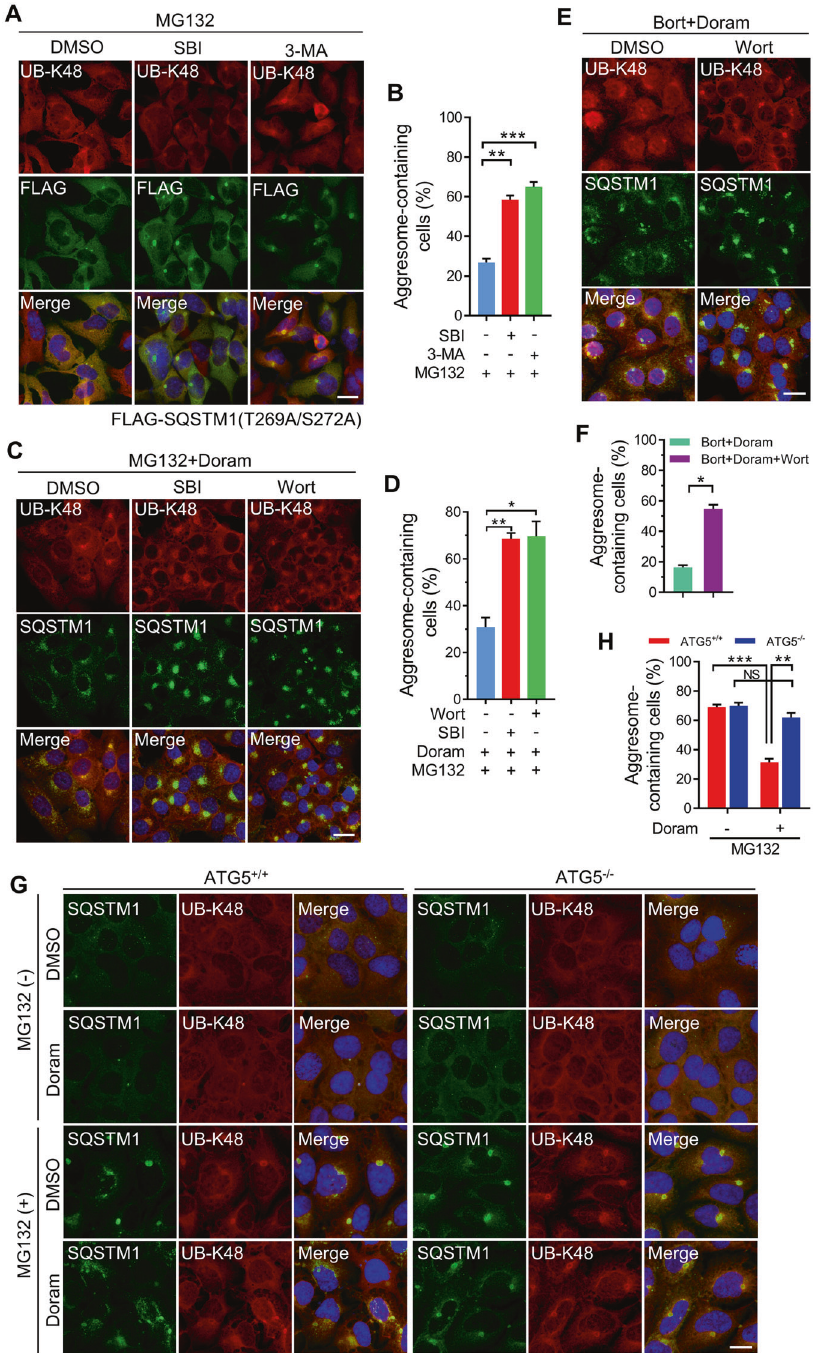
Fig. 5 Blocking autophagy rescues the defective aggresome formation caused by the failure of SQSTM1(T269/S272) phosphorylation. A SQSTM1 knockout AD293 cells stably re-expressing FLAG-SQSTM1(T269A/S272A) were treated with MG132 (2 μ M), or MG132 (2 μ M)/SBI- 0206965 (5 μ M), or MG132 (2 μ M)/3-MA (100 μ M) for 14 h. The aggresome formation was analyzed by immunostaining with anti-UB-K48 (Red) and anti-FLAG (Green) antibodies. Nuclei were stained with DAPI (blue). Scale bar: 20 μ m. B Quantitative analysis of results in ( A ). C A375 cells were treated with MG132 (2 μ M)/Doramapimod (50 μ M), or MG132 (2 μ M)/ Doramapimod (50 μ M)/SBI-0206965 (5 μ M), or MG132 (2 μ M)/ Doramapimod (50 μ M)/Wortmannin (5 μ M) for 14 h. The aggresome formation was analyzed by immunostaining with anti-UB-K48 (red) and anti-SQSTM1 (green) antibodies. Nuclei were stained with DAPI (blue). Scale bar: 20 μ m. D Quantitative analysis of results in ( C ). E A375 cells were treated with Bortezomib (1 μ M)/Doramapimod (50 μ M), or Bortezomib (1 μ M)/Doramapimod (50 μ M)/Wortmannin (5 μ M) for 14 h. The aggresome formation was analyzed by immunostaining with anti-UB-K48 (red) and anti-SQSTM1 (green) antibodies. Nuclei were stained with DAPI (blue). Scale bar: 20 μ m. F Quantitative analysis of results in ( E ). G Wild-type (ATG5 + / + ) or ATG5 knockout (ATG5 − / − ) AD293 cells were treated with DMSO (control), or MG132 (2 μ M), or Doramapimod (50 μ M), or MG132 (2 μ M)/Doramapimod (50 μ M) for 14 h. The aggresome formation was analyzed by immunostaining with anti-UB-K48 (red) and anti-SQSTM1 (green) antibodies. Nuclei were stained with DAPI (blue). Scale bar: 20 μ m. H Quantitative analysis of results in ( G ). For B , D , F , and H , at least 50 cells were randomly selected from each group to score for aggresomes. Data are mean ± SEM of three independent experiments. * P < 0.05, ** P < 0.01, *** P < 0.001, NS = not signi fi cant. Cell Death and Disease (2022)